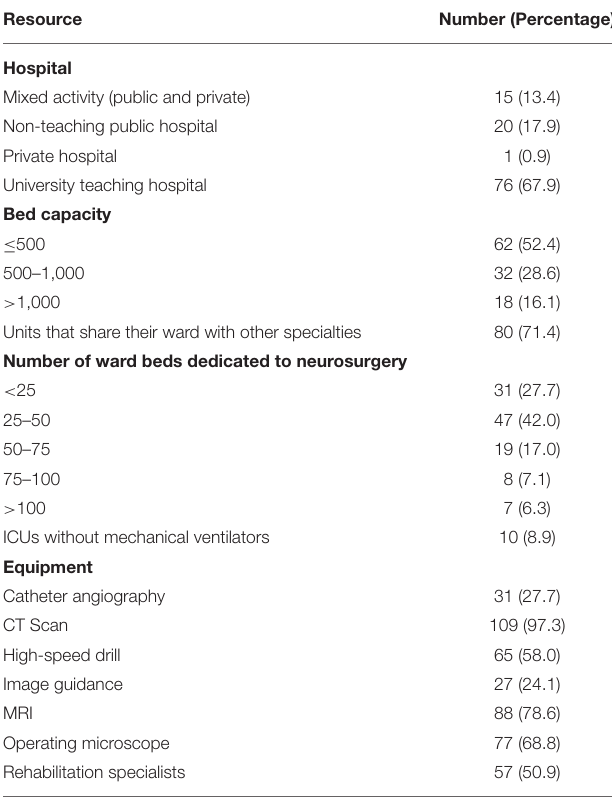
TABLE 2 | Availability of material and human